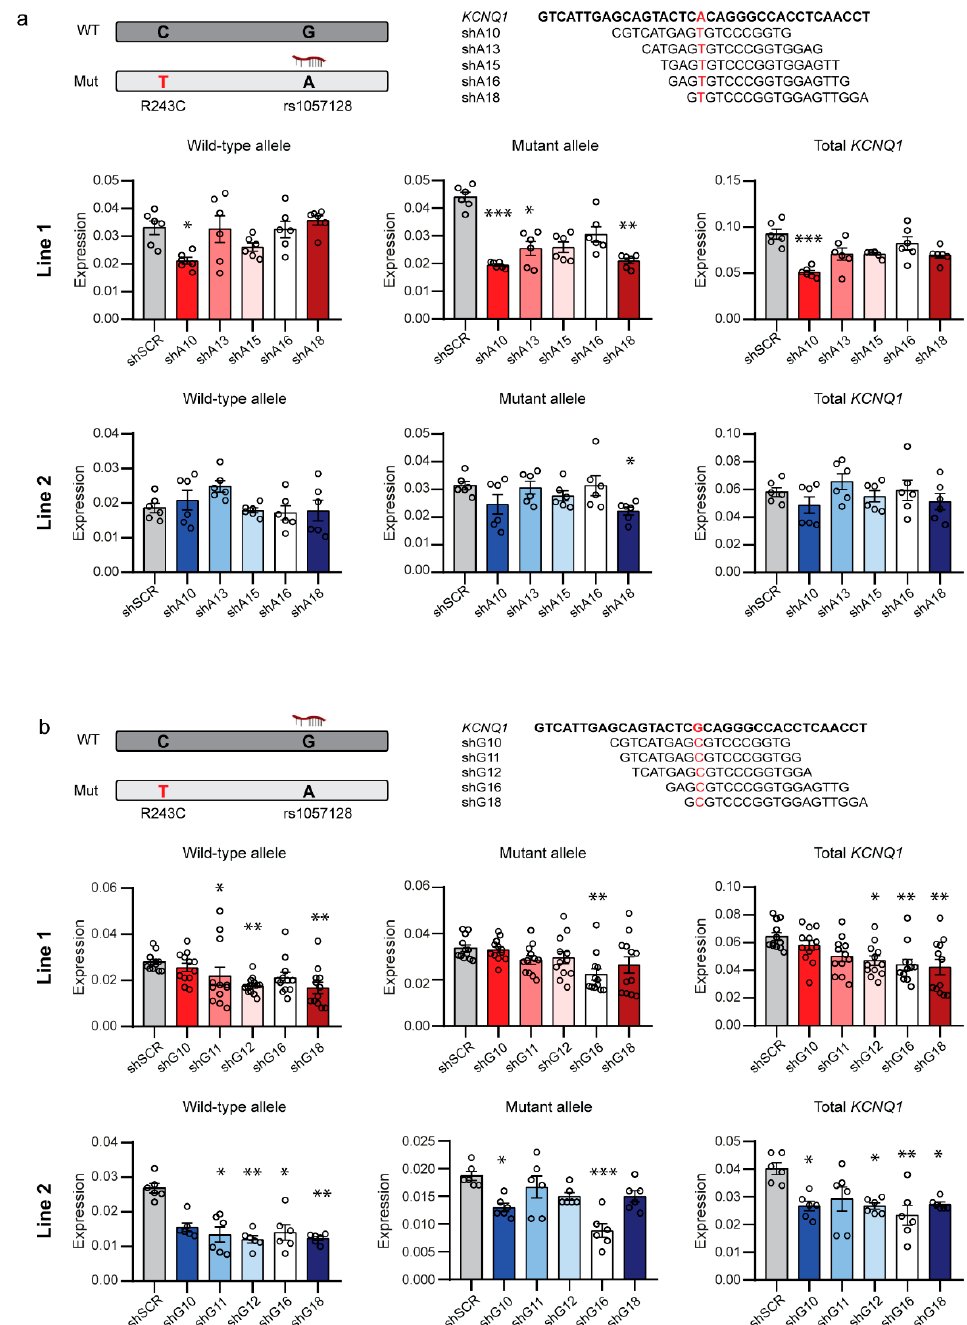
Figure 1. Allele-specific downregulation of KCNQ1 expression in hiPSC-CMs by shRNAs targeting SNP rs1057128: ( a ) Top, schematic representation of the shRNAs targeting the A allele of rs1057128 on the mutant KCNQ1 allele with the mismatch positions indicated in red. Middle, allele-specific relative mRNA expression of the wild-type and mutant allele and total KCNQ1 in hiPSC-CMs of Line 1 ( n = 6). Bottom, allele-specific relative mRNA expression of the wild-type and mutant allele and total KCNQ1 in hiPSC-CMs of Line 2 ( n = 6); ( b ) Top, schematic representation of the shRNAs targeting the G allele of SNP rs1057128 on the wild-type KCNQ1 allele with the mismatch positions indicated in red. Middle, allele-specific relative mRNA expression of the wild-type and mutant allele and total KCNQ1 in hiPSC-CMs of Line 1 ( n = 12). Bottom, allele-specific relative mRNA expression of the wild-type and mutant allele and total KCNQ1 in hiPSC-CMs of Line 2 ( n = 6). * p < 0.05; ** p < 0.025; *** p < 0.001 compared to shSCR negative control shRNA; error bars indicate